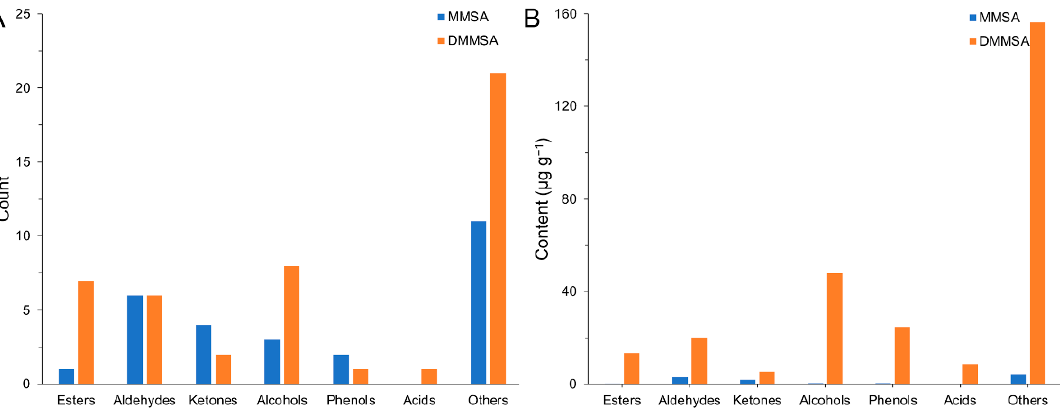
Figure 5. ( A ) The number of different types of volatiles in MMSA and DMMSA; ( B ) The content of different types of in MMSA and DMMSA.